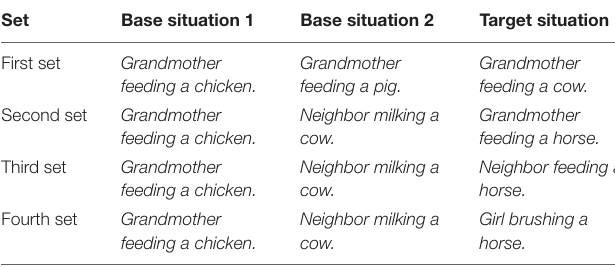
FIGURE 6 | Creation of a new schema concept called hunting schema with two instances ( hunting_t and hunting_b ). The schema creation happens through transformation of mapping agents (the shapes in blue called corr ) into concepts. The mappings themselves are transformed into a distributed representation of the new schema concept. The mapped elements from the target and the base form two instance agents, which are the first instances of the new schema concept. The red circle on the left refers to the initially encoded target situation. The red circle on the right refers to the initially encoded base situation. The middle red circle covers all mappings generated by